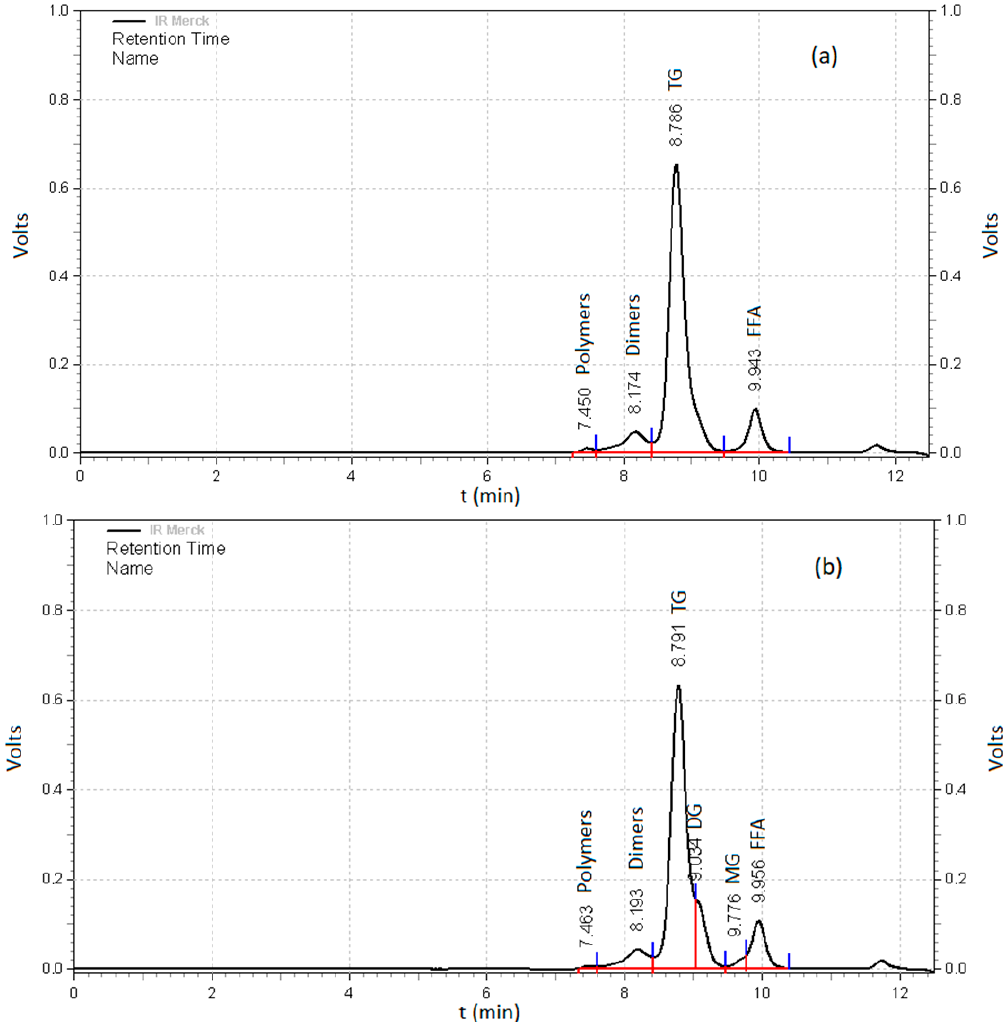
Figure 4. HPSEC chromatograms of the waste cooking oil before ( a ) and after ( b ) glycerolysis.